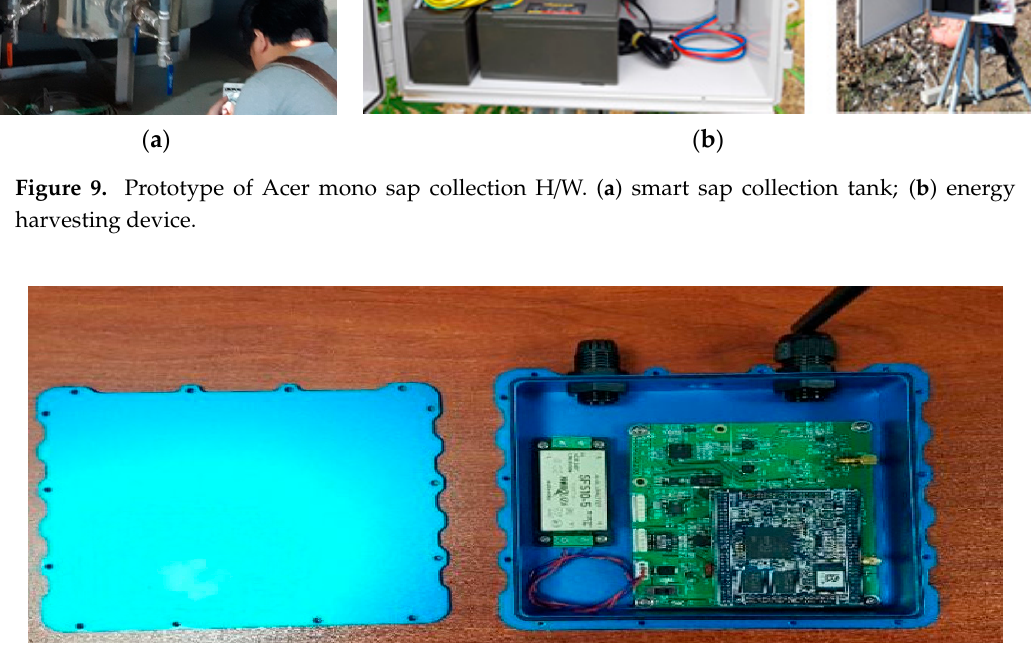
Figure 9. Prototype of Acer mono sap collection H/W. ( a ) smart sap collection tank; ( b ) energy harvesting device.